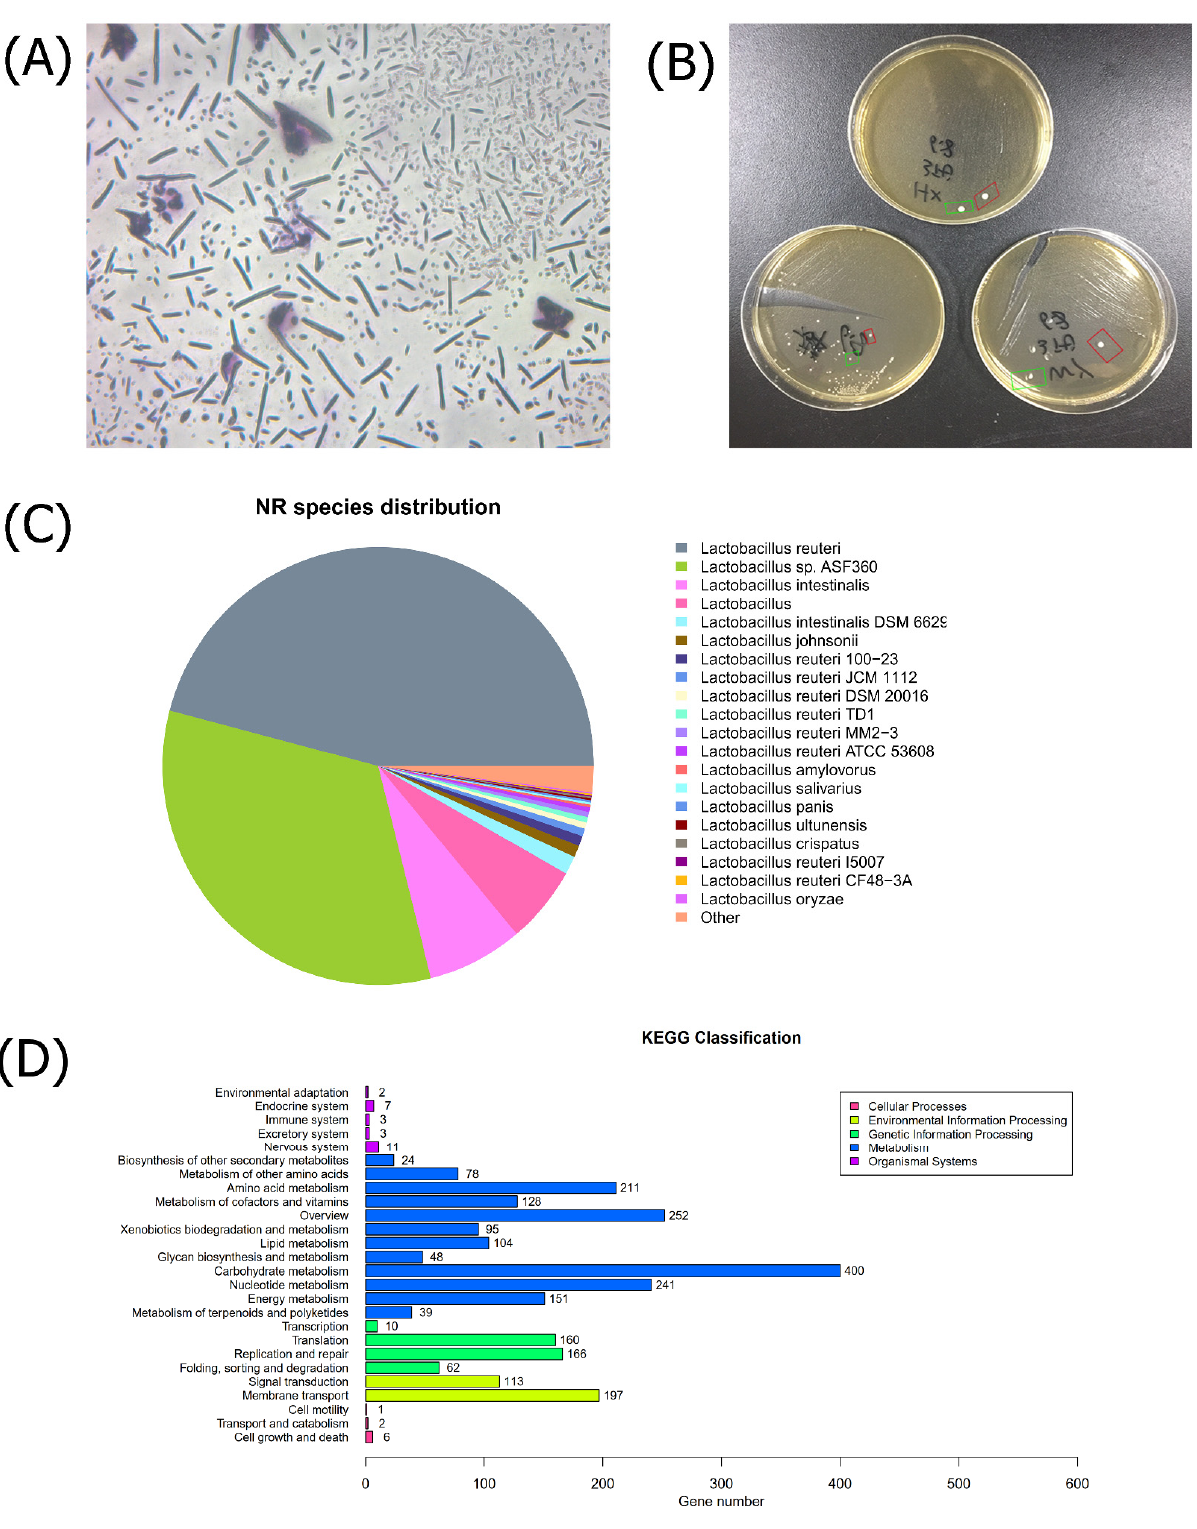
Figure 1. Identification of bacteria. ( A ) Gram staining is positive (200 × ). ( B ) The hydrogen peroxide test is negative. ( C ) Pie chart of homologous species classification in NR database, where each sector represents a species. The larger the fan-shaped area, the greater the number of similar sequences between the FDM strain and this strain. The area of fan-shaped is less than 50%. ( D ) Kyoto encyclopedia of genes and genomes (KEGG) for functional annotation of genomes or transcriptomes.